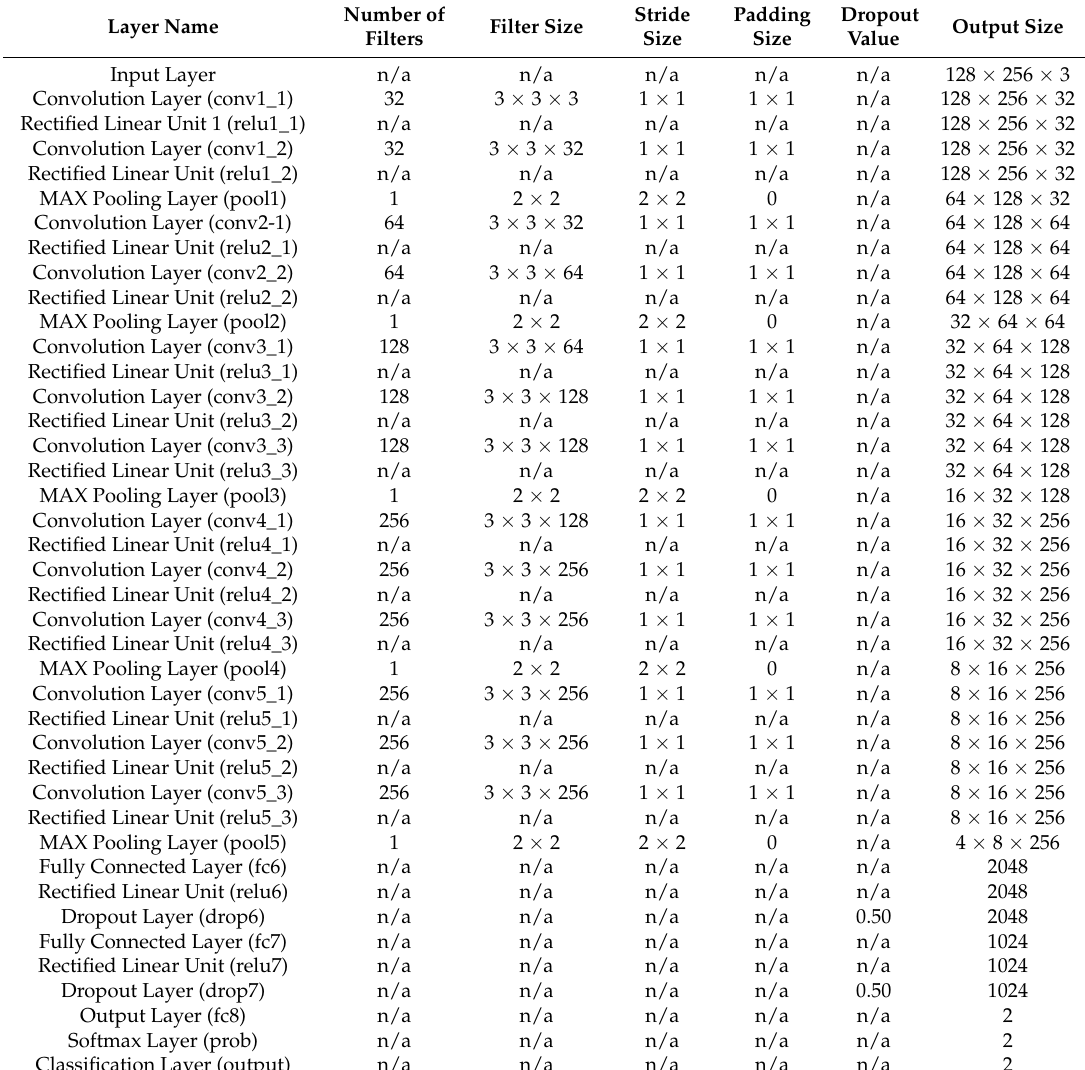
Table 5. Description of customized VGG-16 network for PAD